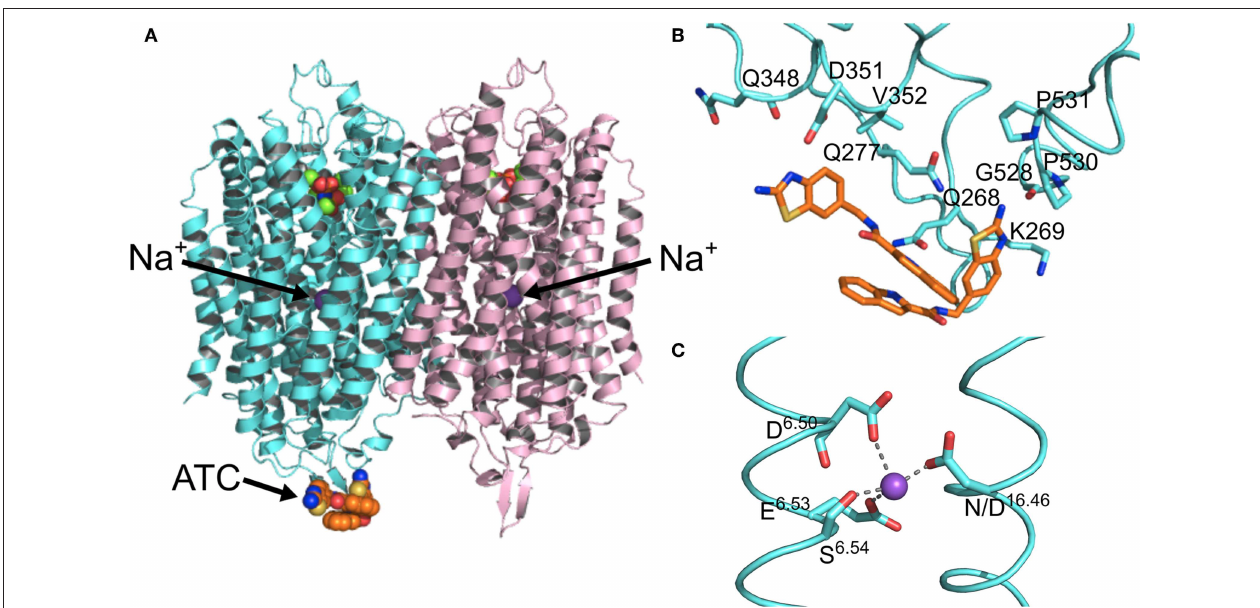
FIGURE 3 | Structural asymmetry. (A) The location of the ATC molecule (orange spheres) and the Na + ion (purple sphere) in the mPPase dimer. (B) The binding of the two ATC molecules (orange sticks) to the β 1-2 loop, loop 8-9, and loop 12-13, with the interacting residues shown at sticks (Tm -PPase numbering). (C) The tetracoordination of Na + (purple sphere) at the ionic gate. (PDB: 6QXA) ( Vidilaseris et al., 2019). moves downwards by about 2 Å compared to the resting state.